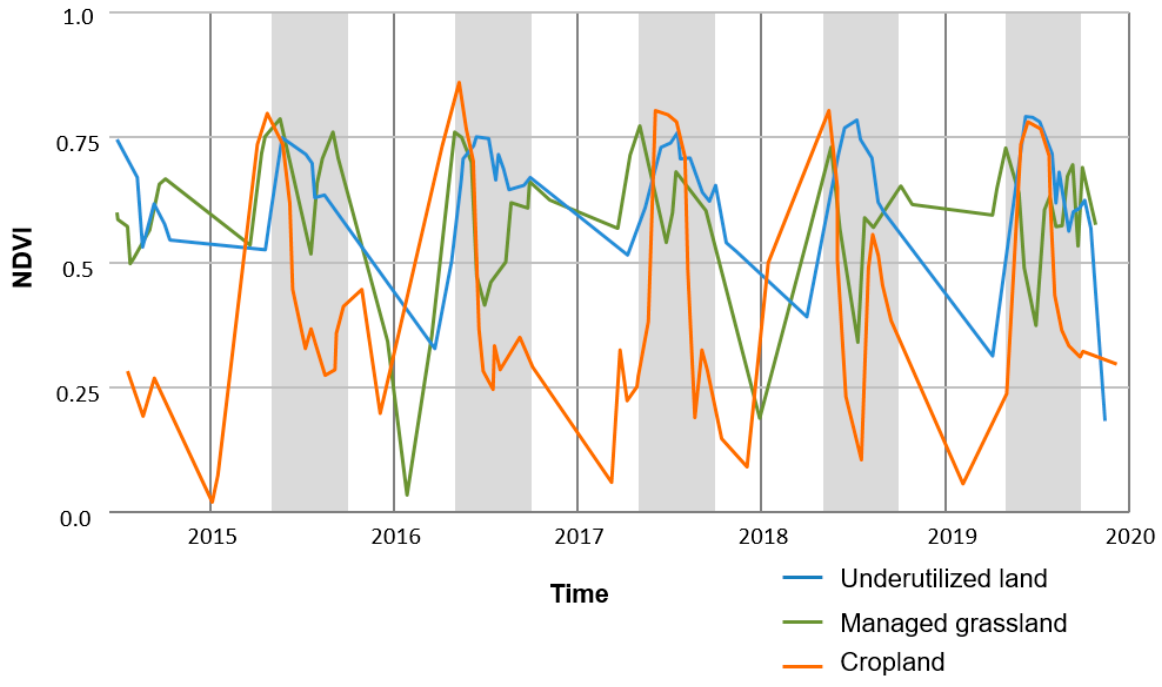
Figure 5. L8 NDVI phenological profiles of cropland (orange), managed grassland (green), and underutilized land (blue) in the Continental biogeographical region. The growing season (beginning of May until end of September) is indicated in grey.